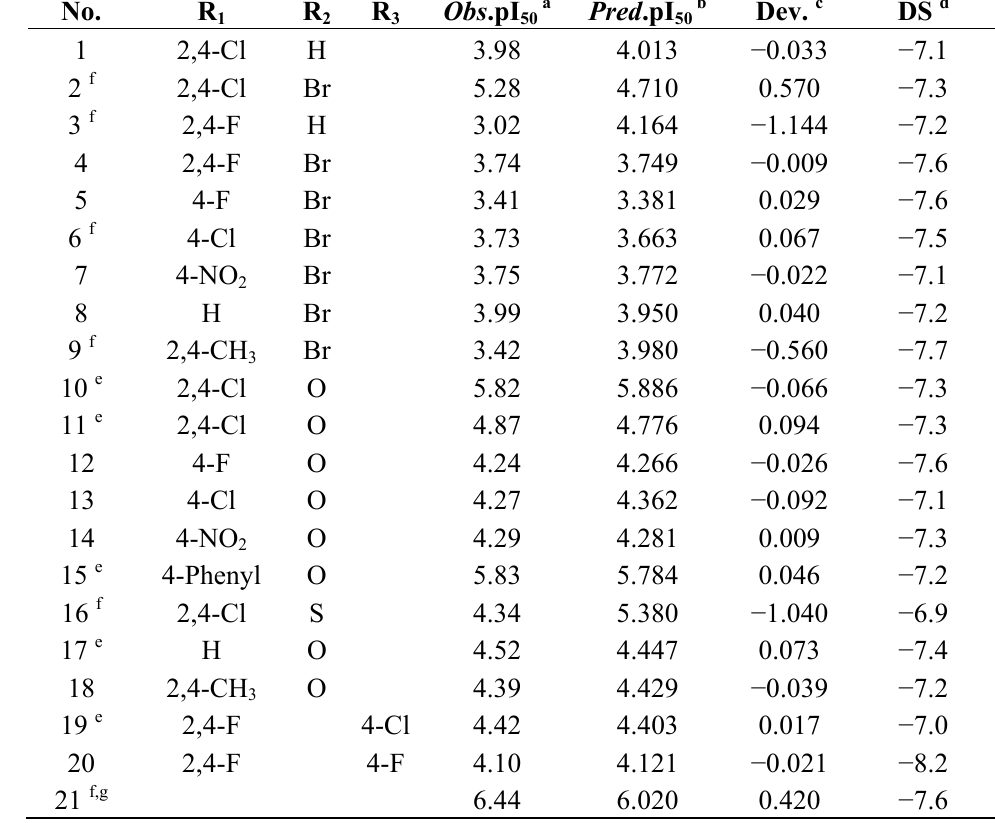
Table 1. Observed activities ( Obs.pI of the Mtb inhibitory activities of